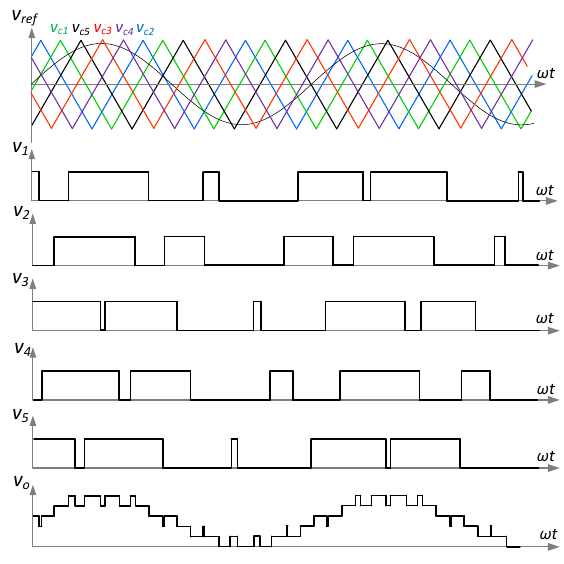
Figure 2. PS-SPWM output waveform generation.